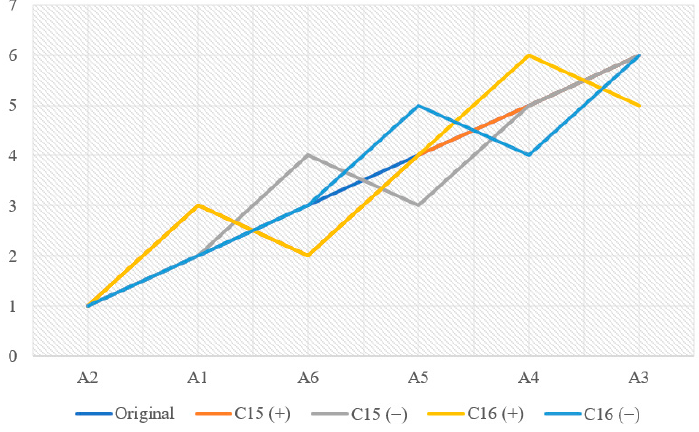
Figure 2. Sensitivity